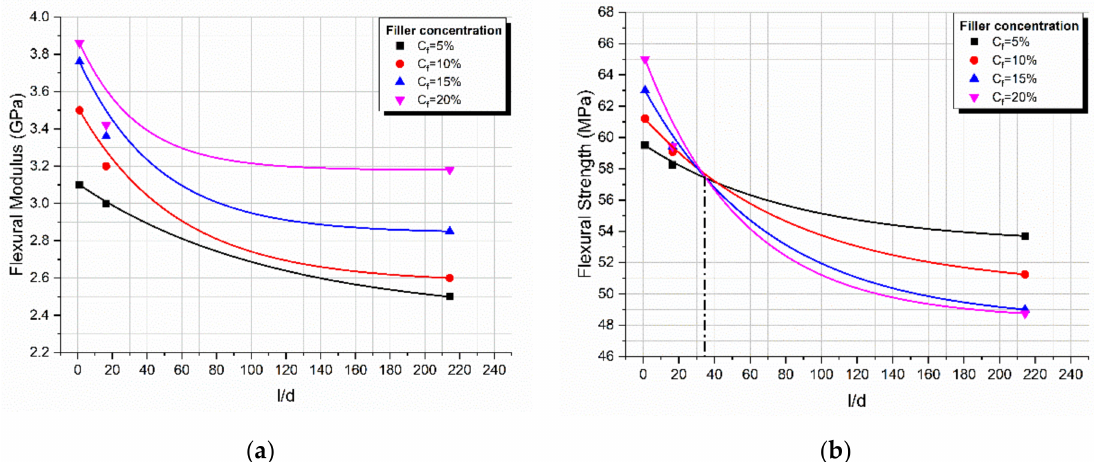
Figure 10. Variation with filler aspect ratio l / d for different filler loadings of ( a ) the flexural modulus and ( b ) the flexural strength.